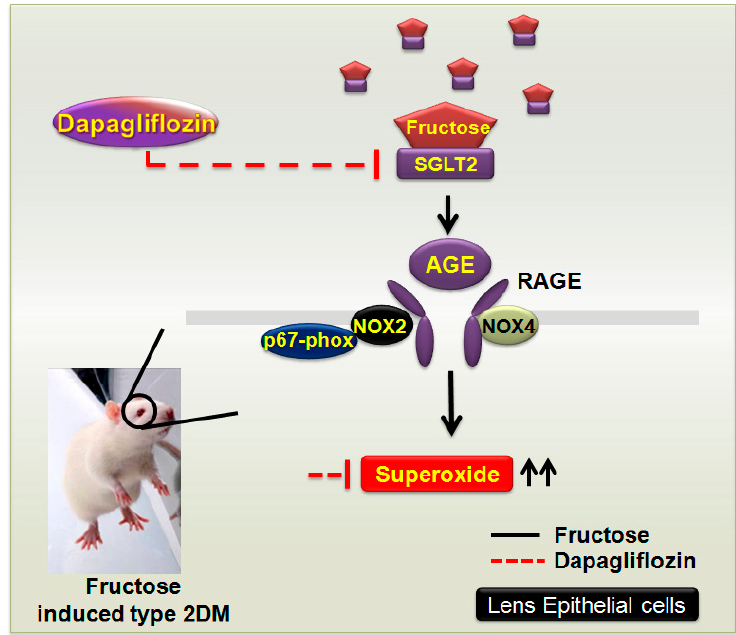
Figure 5. Dapagliflozin decreases the fructose-induced NOX2/4-dependent oxidative stress in the lens that is mediated by a sodium-glucose cotransporter 2 (SGLT2)-dependent mechanism in a rat model of type 2 diabetes mellitus (DM). Fructose increases the generation of reactive oxygen species by the SGLT2-induced upregulation of the expression levels for advanced glycation end products (AGE), the receptor for AGE (RAGE), and NADPH oxidase isoforms (NOX2/4) in lens epithelial cells of rats (black line). The SGLT2 inhibitor dapagliflozin acts as an important regulator of fructose by downregulating the SGLT2-induced activity of AGE-RAGE-NOX2/4 (red line).